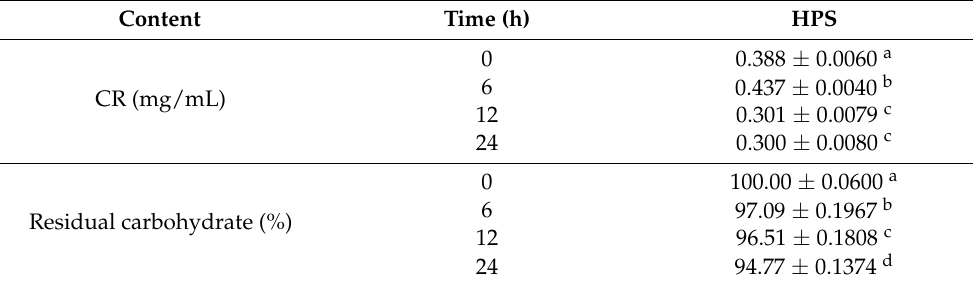
Table 3. Changes in CR and residual carbohydrate HPS during in vitro